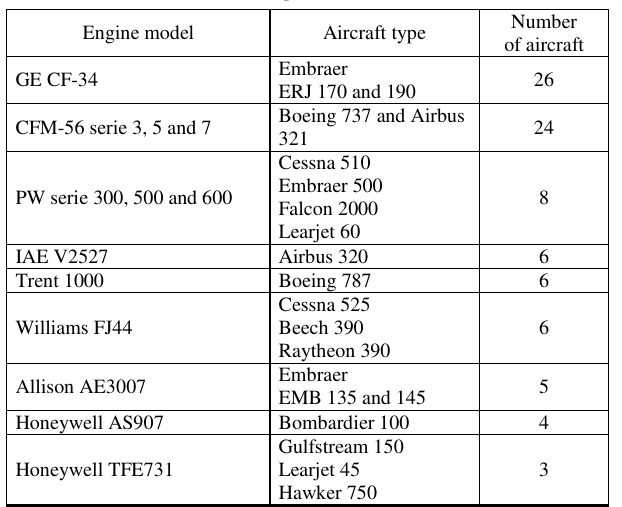
Table 15. Type and number of the aircraft powered by jet turbine power- plants